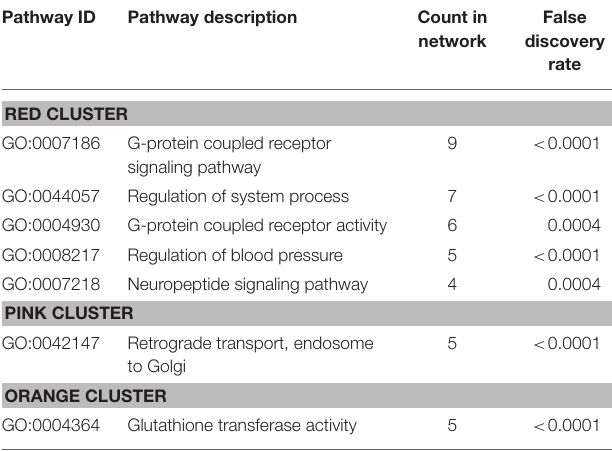
depth PPI analysis all significantly regulated genes (less stringent filtering, criteria p ≤ 0.01, absolute fold change ≥ 1.2) were used.